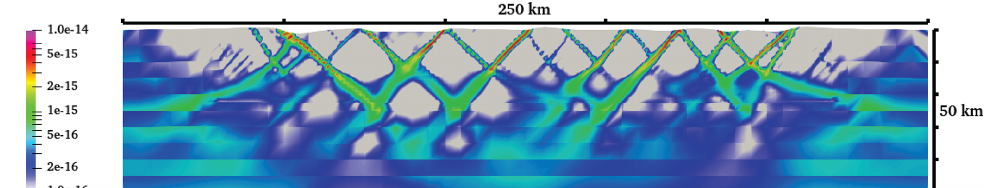
Figure B5. Cross section at y = 300km, showing the strain rate attribute through 10Myr of the model run. This section crosses the centre of the weak domain. See Fig. 4c for a 10Myr snapshot. Screenshot taken at 10Myr.